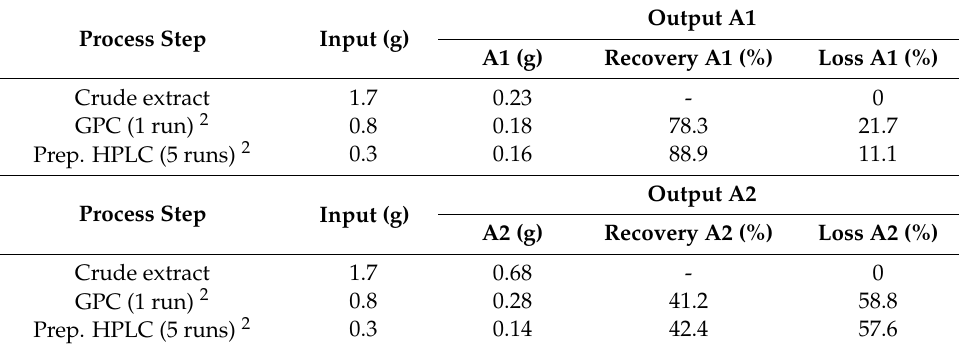
Table 2. Mass balance of the input and the output of major unit operations in the supernatant downstream processing.